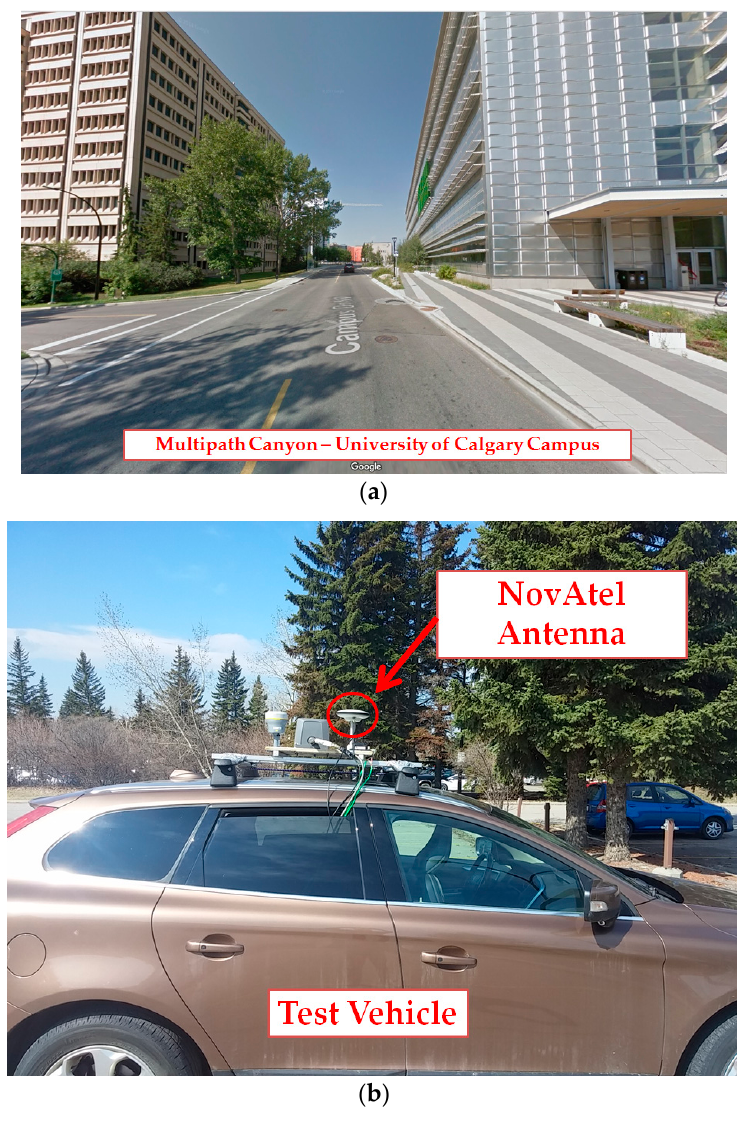
Figure 10. ( a ) Kinematic data collection—Multipath canyon—University of Calgary; ( b ) Test vehicle and NovAtel antenna for GPS data collection.